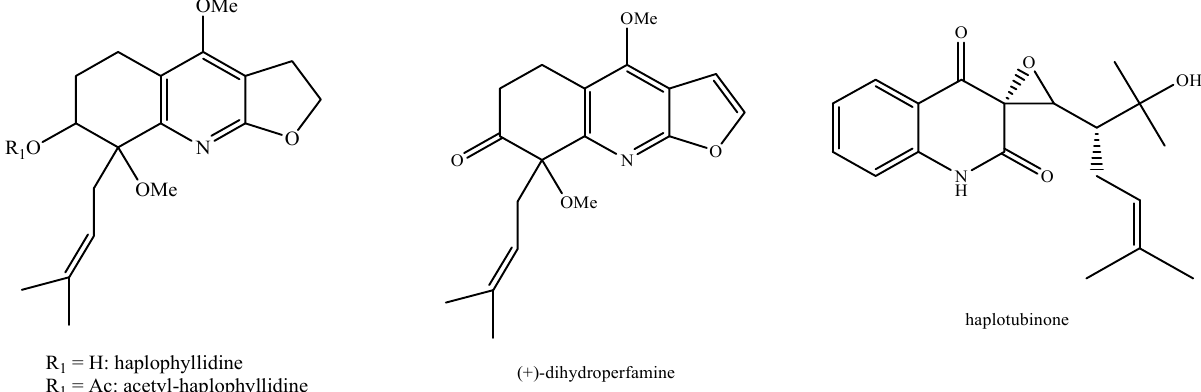
Figure 7. Structure of the alkaloids identified in Haplophyllum species—part 3.